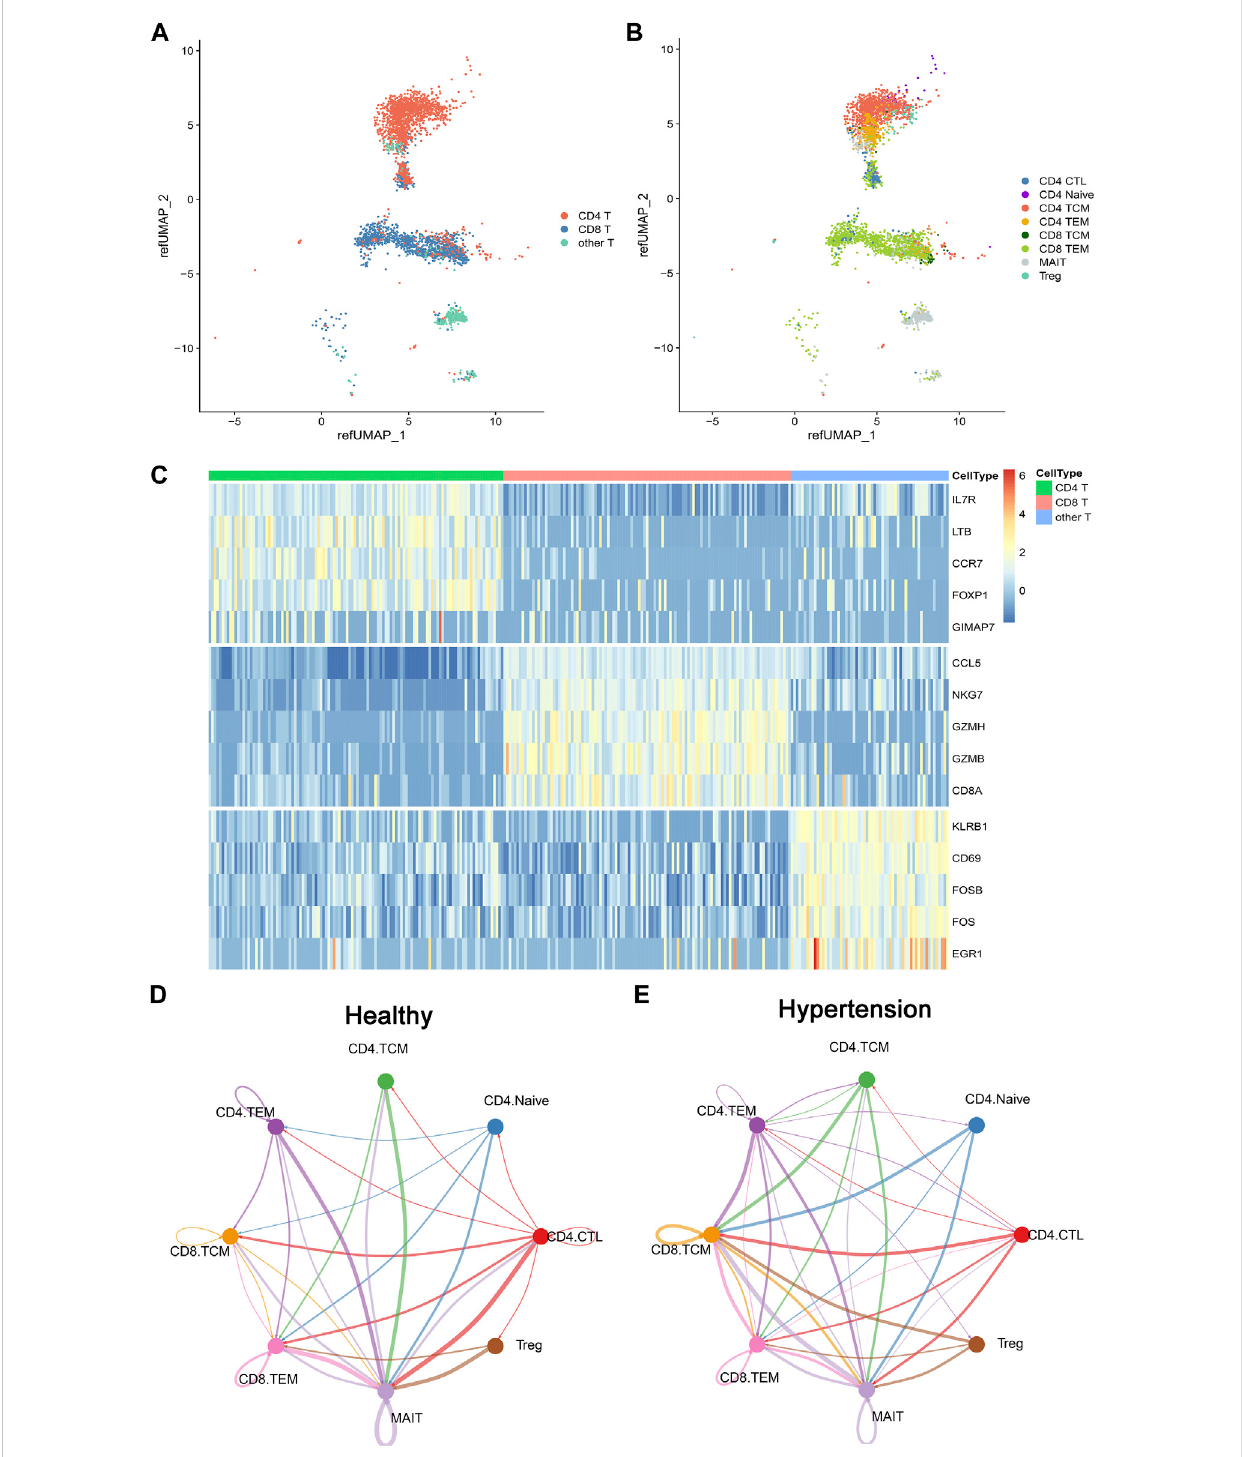
FIGURE 1 Overview of T cells from 10 integrated samples. (A) Uniform manifold approximation and projection (UMAP) visualization of T cells colored by three cell types. (B) UMAP visualizationcoloredbyeight T-cell subtypes. (C) Heatmapshows theexpression ofmarkergenes across CD4Tcell, CD8Tcell, and other T cells. (D) CellChat analysis of the communications between memory T-cell populations in healthy donors. The number of signi fi cant ligand – receptorpairsbetweenanypairoftwocellpopulations.Theedgewidthisproportionaltotheindicatednumberofligand – receptorpairs. (E) CellChat analysis of the communications between memory T-cell populations in hypertensive